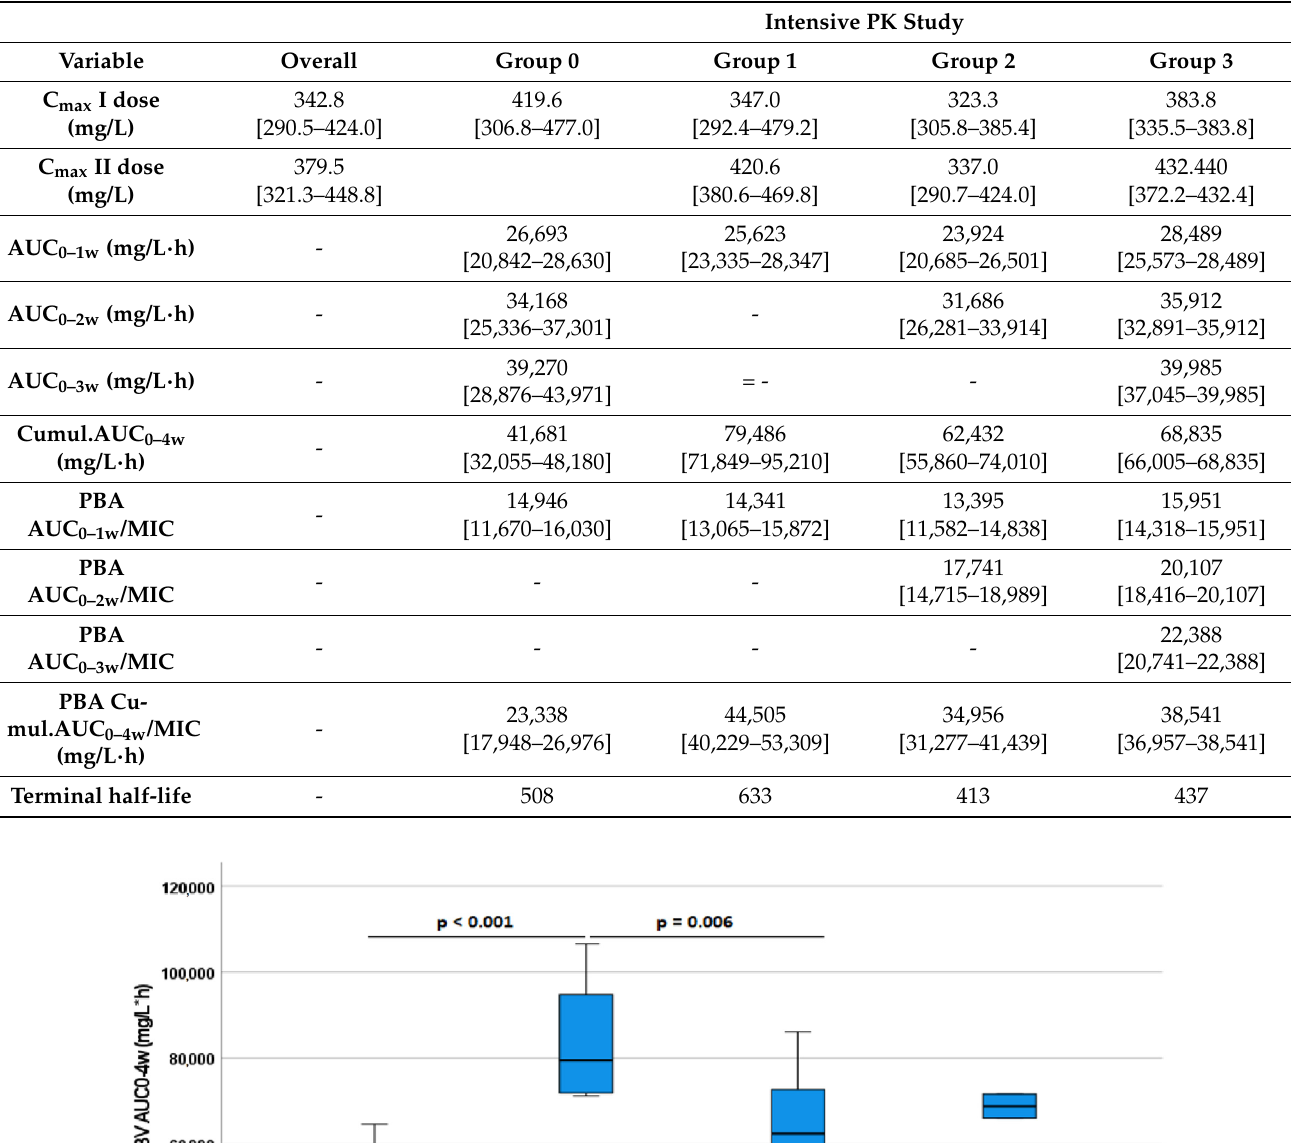
Table 3. Main PK and PK/PD characteristics, by dosing group, including protein-binding-adjusted (PBA) parameters. -: not applicable.